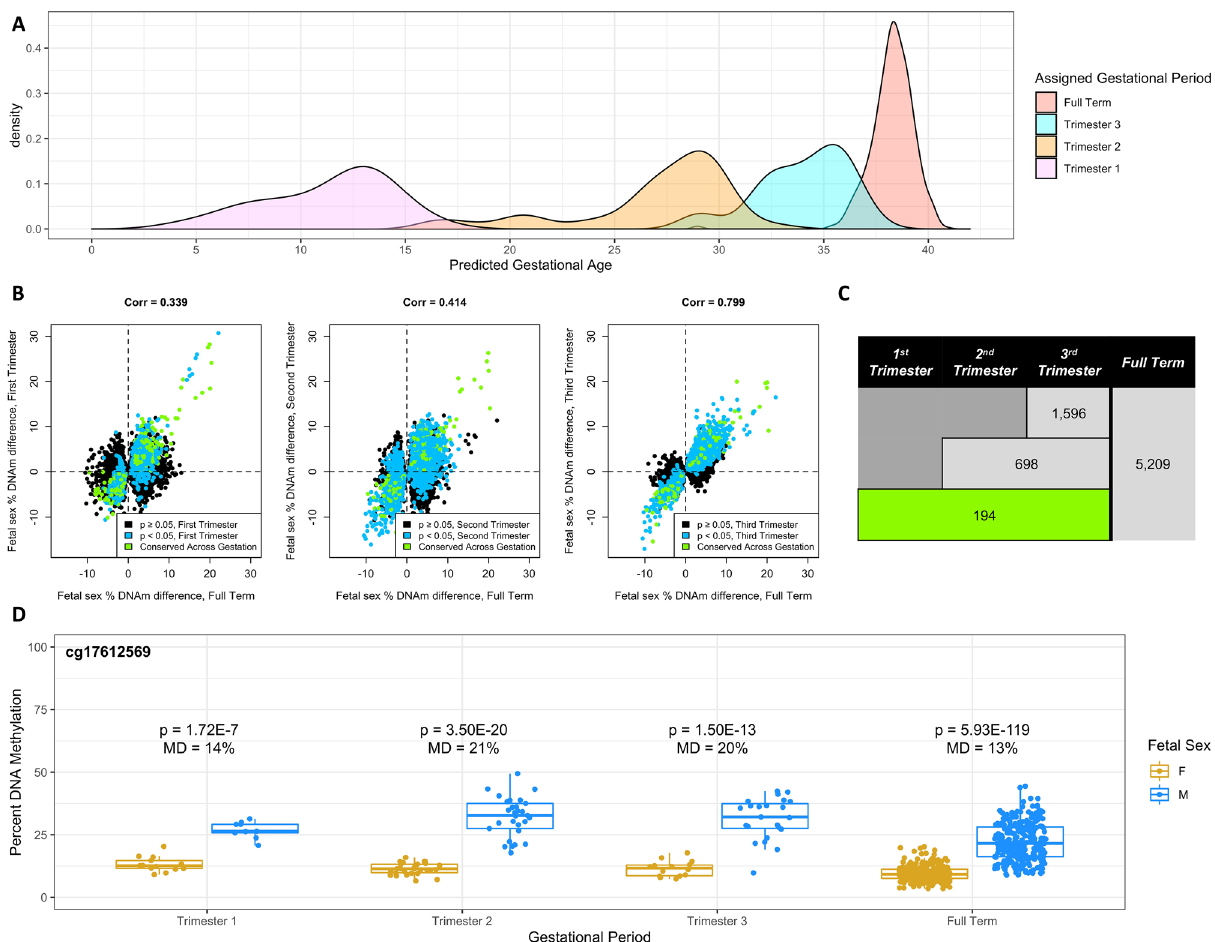
Figure 3. Persistence across the gestational period. ( A ) Distribution of predicted gestational age (via predictAge() function from the planet R package) in full term and individual trimester datasets ( B ) The persistence correlation analysis shows plots of DNA methylation differences for the three trimesters. The green colored points are the CpG sites that were conserved across gestation. The blue colored points represent the CpG sites that were considered significant for each trimester. The correlation values between the trimester and the full term analysis increase as the full term is approached. ( C ) Persistence of hits discovered from the full term placentas throughout gestation. If the significant site from the full term had a p value less than 0.05 and had the same direction of association in the preterm analysis, then it was considered “persistent.” For example, of the 5,209 differentially methylated sites identified in the full term sample that passed QC in all three individual early term samples, 194 CpG sites were persistent per this definition across all three trimesters. ( D ) Comparison of female and male fetuses’ methylation values at different points during gestation. cg17612569 was consistently significant at all time